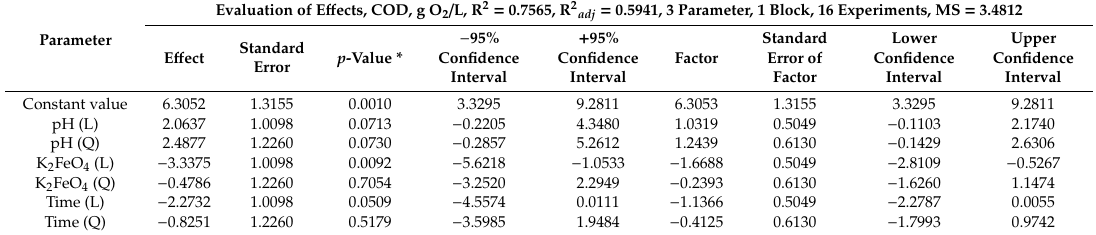
Table 7. Analysis of the experiments using CCD with Statistica 13—evaluation of e ff